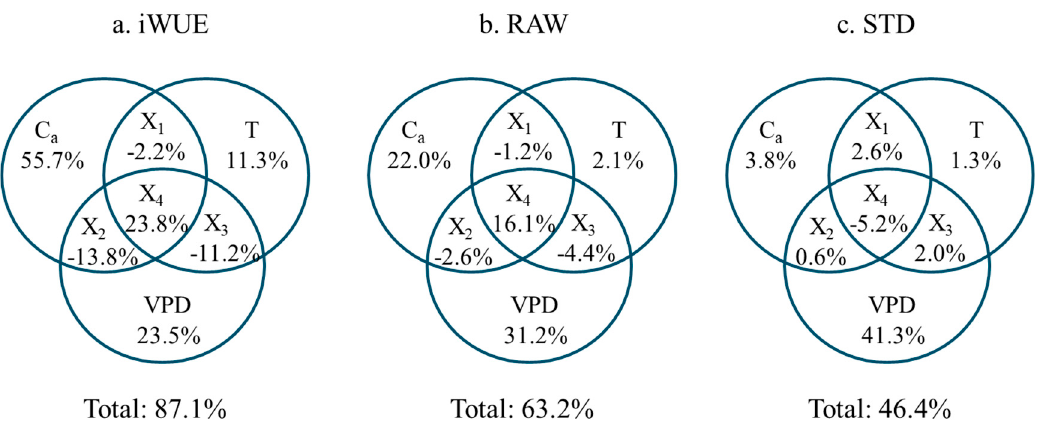
Figure 8. Radial growth and changes in iWUE as explained by the commonality analysis. The analysis combinations are as follows: pure effect of atmosphere CO 2 concentration ( C a ), pure effect of temperature (T), pure effect of vapor pressure deficit (VPD), comprehensive impact by atmosphere CO 2 concentration and temperature (X 1 ), comprehensive impact by atmosphere CO 2 concentration and VPD (X 2 ), comprehensive impact by temperature and VPD (X 3 ), and comprehensive impact by all predictors (X 4 ). The corresponding percentage values represent the explained variance of each fraction. RAW represents the original tree-ring width chronology; STD represents the de-trended width chronology using the spline function method.